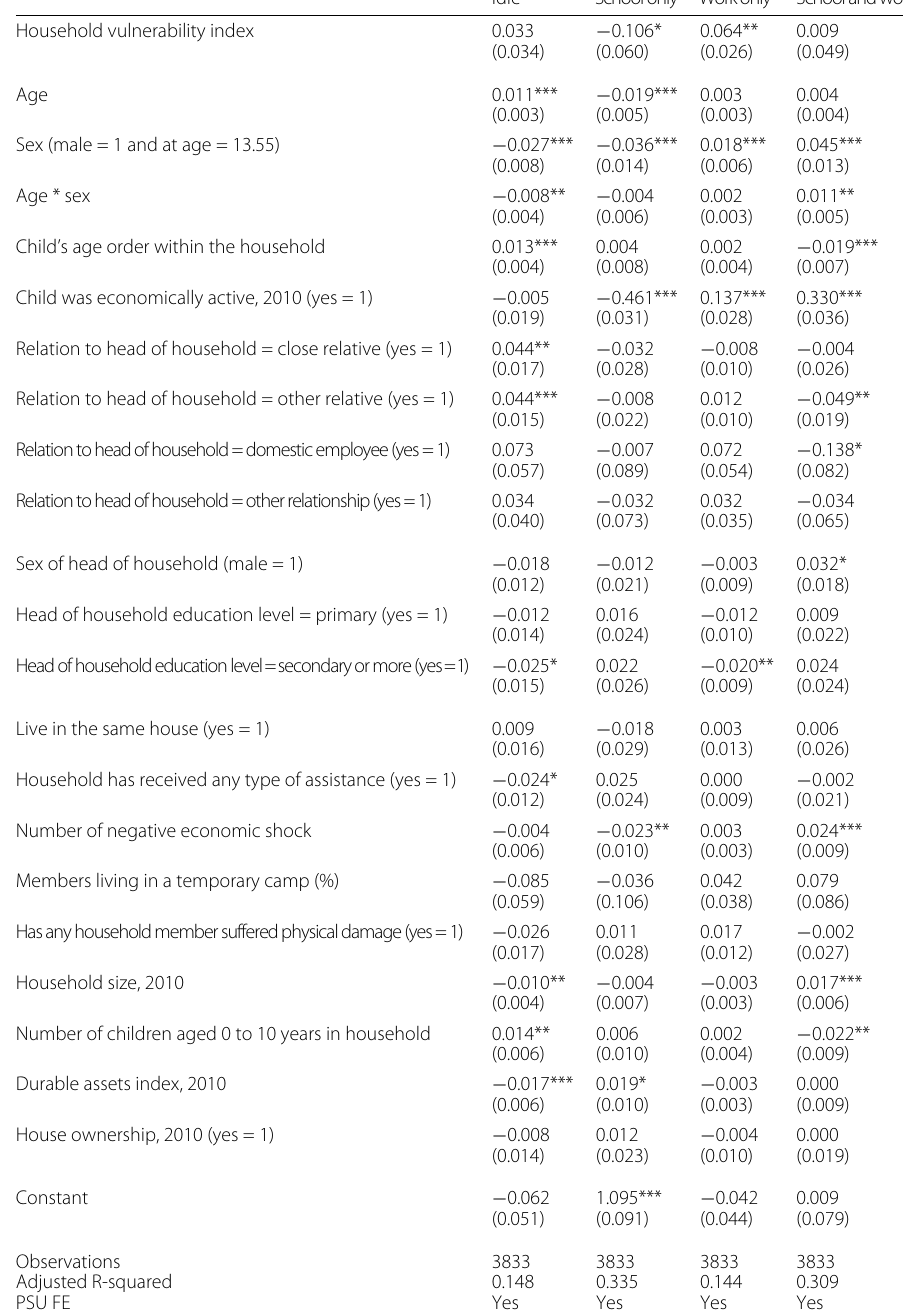
Table 5 Fixed-effects model, school/work